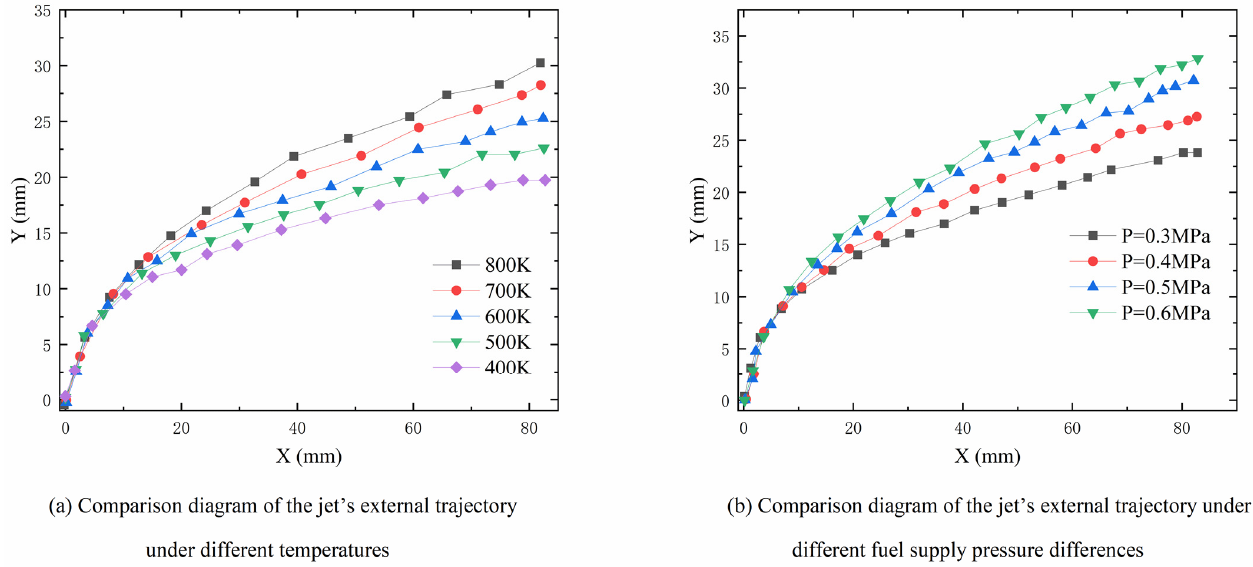
Figure 7. Comparison diagram of the jet’s external trajectory under different temperatures and fuel supply pressure differences.